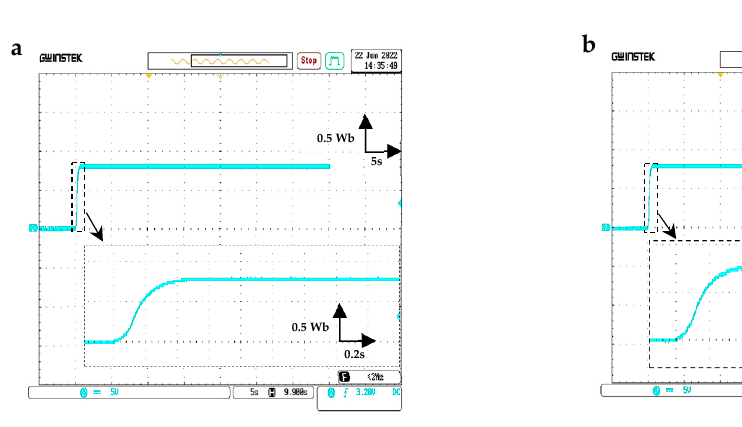
Figure 22. Rotor flux magnitude for speed profile 1 and 2.